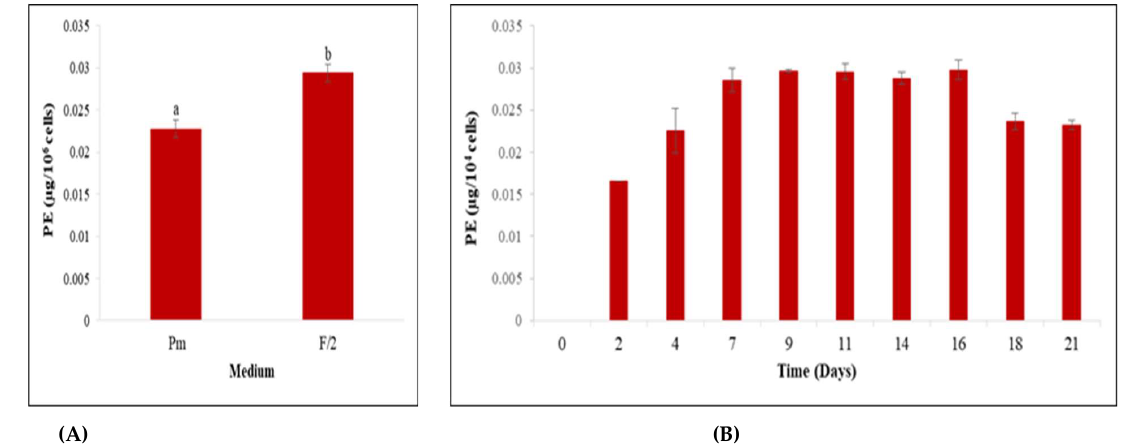
Figure 2. PE production capacity by Rhodomonas sp. strain. ( A ) Comparison of modified F/2 and Pm medium; ( B ) time-course using modified F/2. (Data are means ± SE. Columns labeled with different low case letters (a, b) indicate statistically significant differences ( p < 0.05, ANOVA, Duncan multiple range tests)).